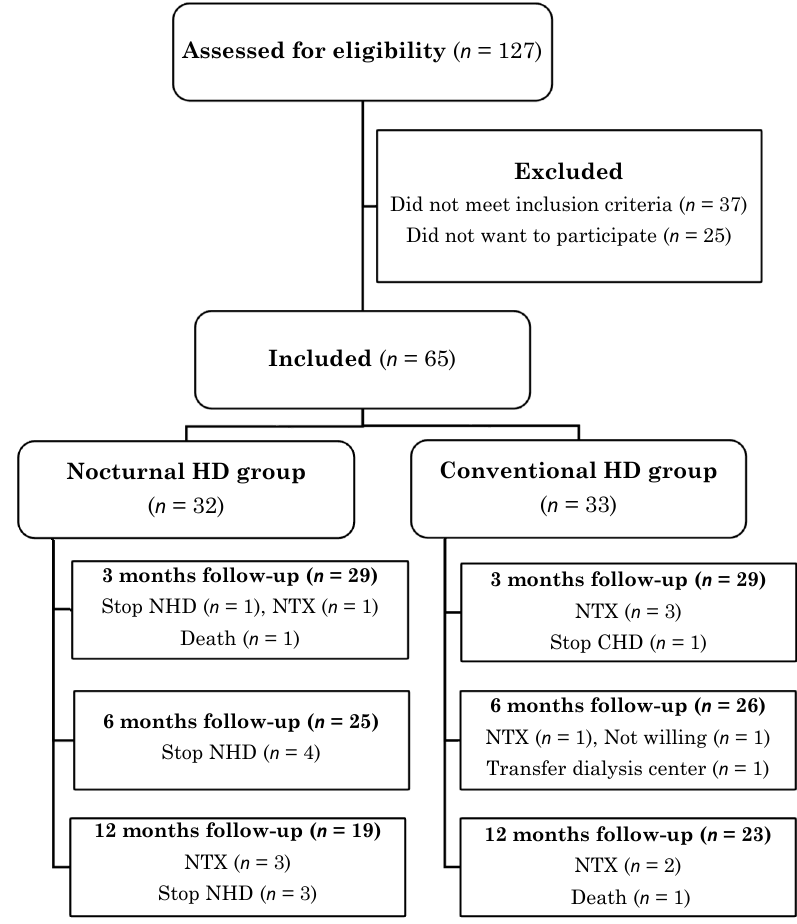
Figure 1. Participant flow diagram.